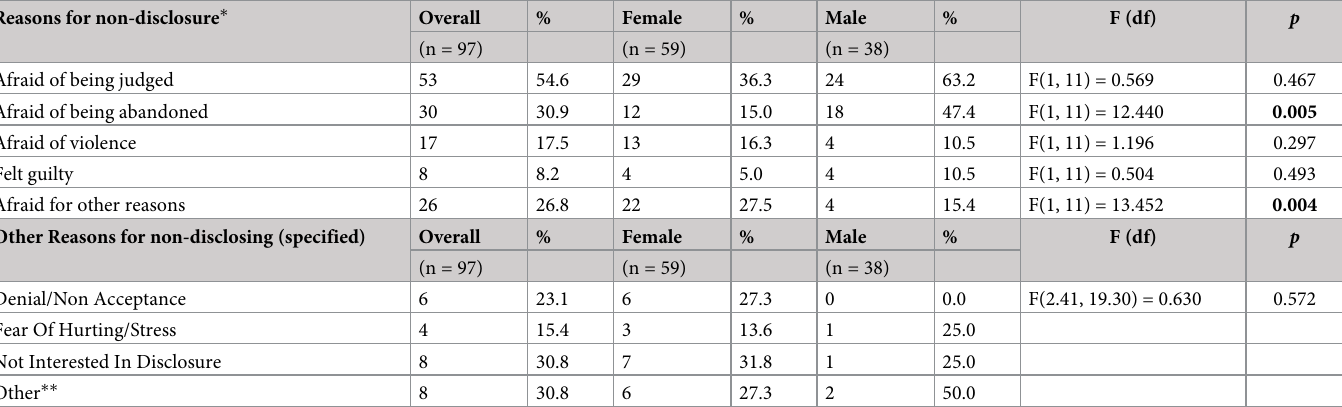
Table 3. Reasons for non-disclosure of HIV status, by sex and adjusted for community clustering. Reasons for non-disclosure * Overall